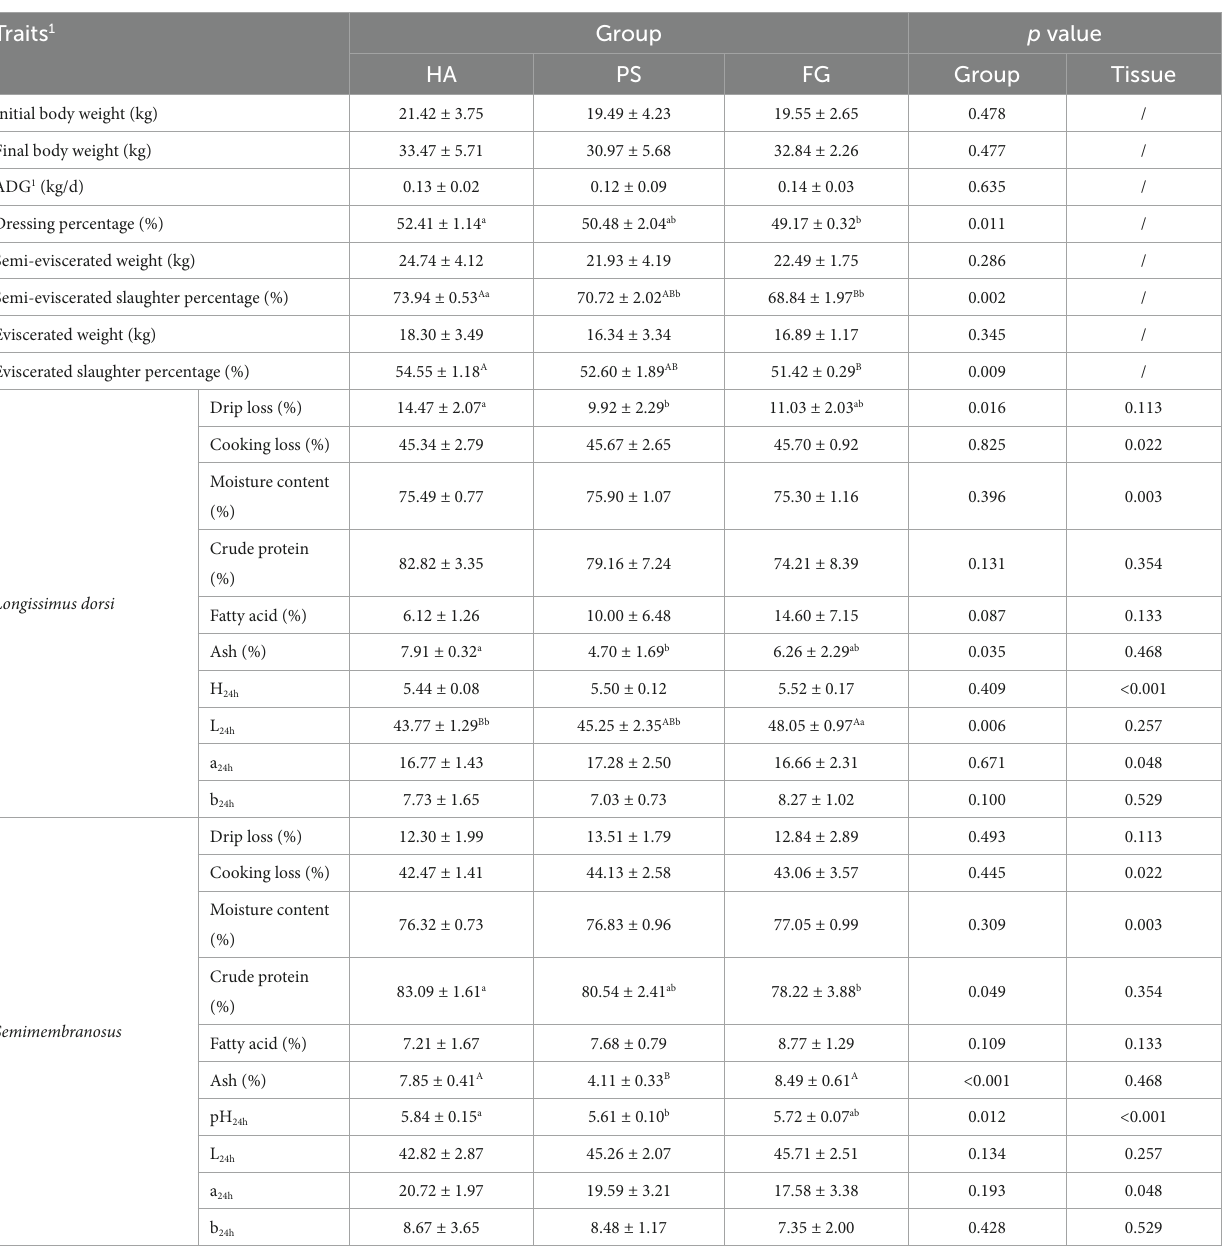
TABLE 1 Growth and carcass traits in goats under different forage treatments. Traits 1